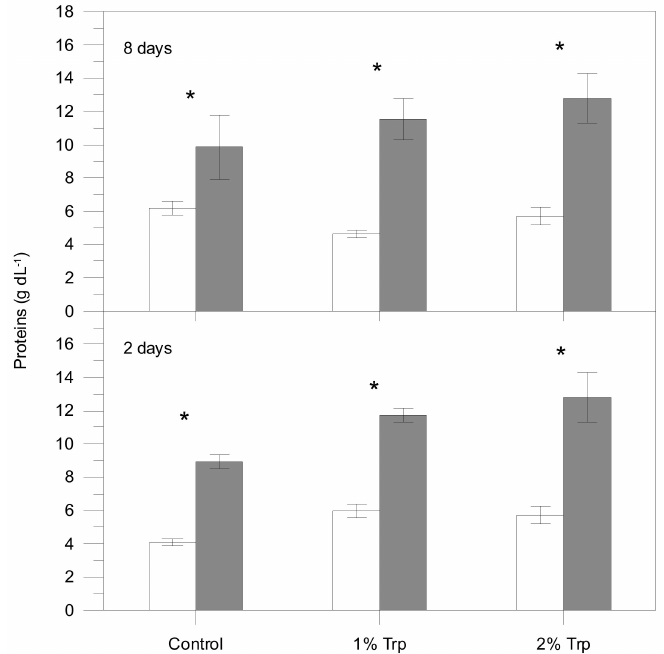
Figure4. Plasma proteins concentration foreach treatment(mean ± SE). Whiteand grey barsare pre- and post-stress values, respectively. Asterisks indicate significant di ff erences between pre- and post-stress conditions. Di ff erent letters indicate significant di ff erences among groups (di ff erent experimental feeds) within each sample (pre- and